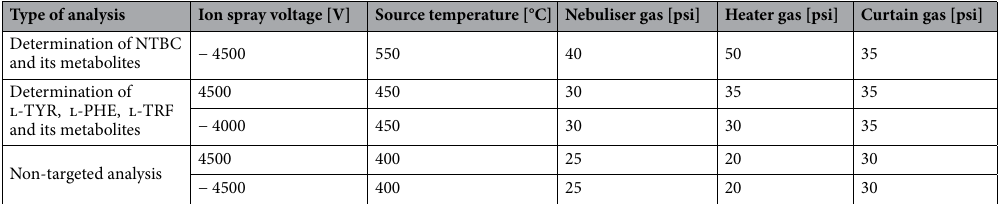
Table 1. Source-dependent parameters for